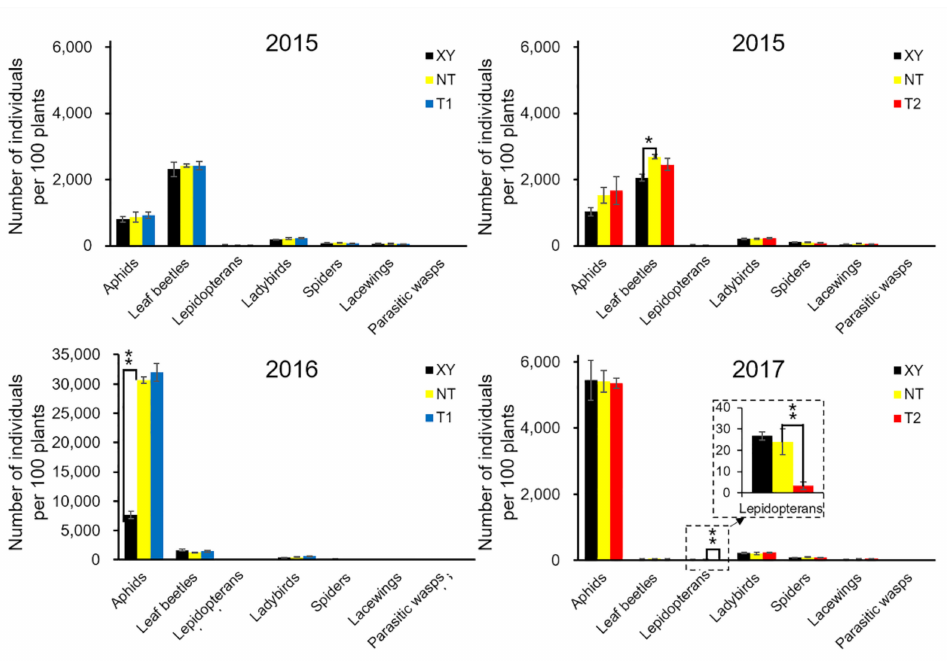
Figure 2. From 2015 to 2017, the cumulative number of main arthropod groups in the field of cultivated variety XianYu335 (XY), non-transgenic recipient variety DBN318 (NT), transgenic maize DBN9868 (T1) and DBN9936 (T2) over the growth season. The Y-axis shows the cumulative number of individuals per 100 plants during the growth period, and the X-axis shows the arthropod groups. We only compared XY with NT and NT with T1 or T2 by using a Student’s t -test. Asterisks denote significant differences, where p < 0.05 (*), p < 0.01